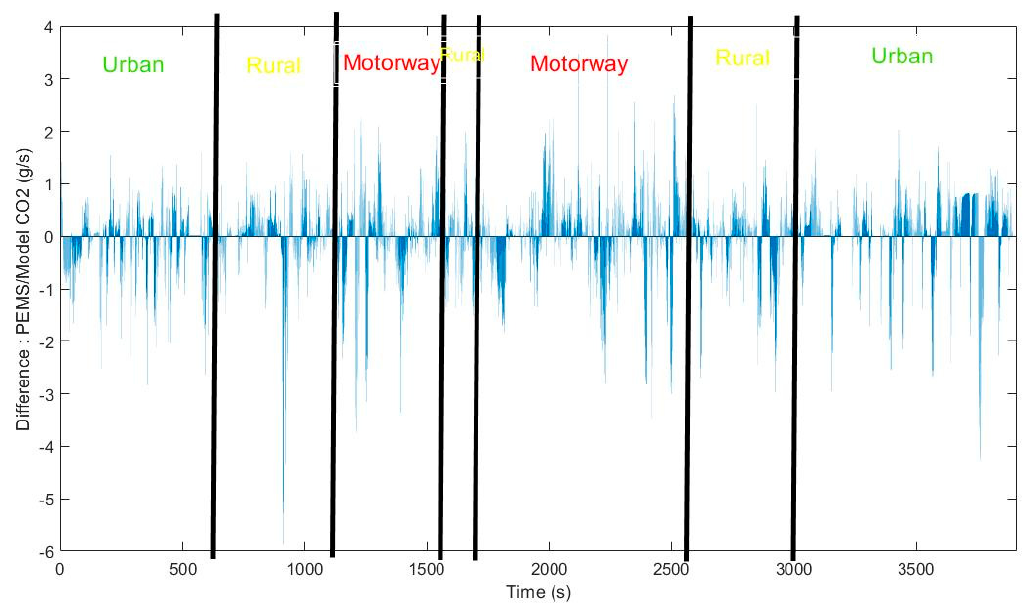
Figure 11. Differences of CO 2 emissions obtained results from PEMS and emission model calcula- tion.